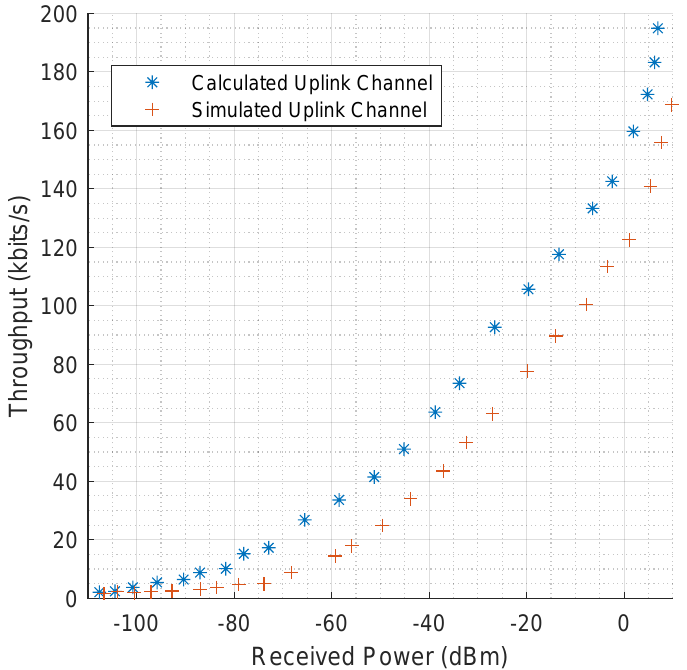
Figure 7. Both simulated and calculated throughput measurements (kbits/s) for NB-IoT uplink channels which are based on the received power